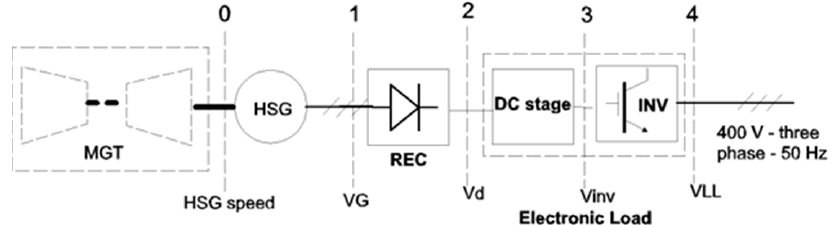
Figure 7. Basic scheme for High-Speed Generator (HSG) connection in generation